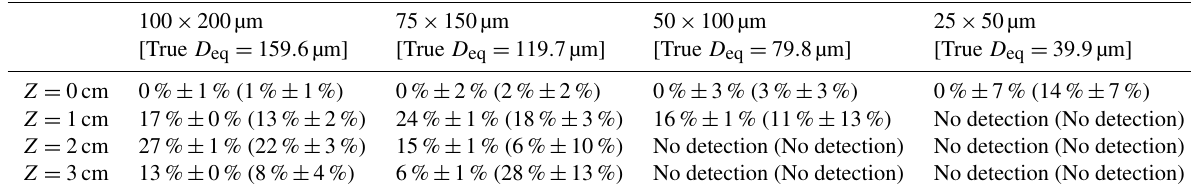
Table 2. Theoretical (measured) relative uncertainty (cid:49)D eq = ε ± σ for the four opaque short columnar shape particles shown in Fig. 9 with three orientations (0, 45, and 90 ◦ ) of equal probability. ε represents the relative mean error and σ its relative standard deviation (due to the pixel effect) from the true D eq . For the 25 × 50µm short columnar particle at Z = 0, only images with more than 4 pixels are